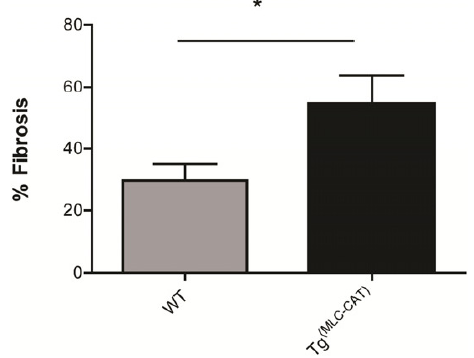
Figure 7. Increase in fibrosis Tg (MLC − CAT) mice. Quantitative assessment of fibrosis (expressed as percent of left ventricle) was increased in Tg (MLC − CAT) mice as compared to WT mice. Values are mean ± SEM; n = 4–5 per group; * p < 0.05 t